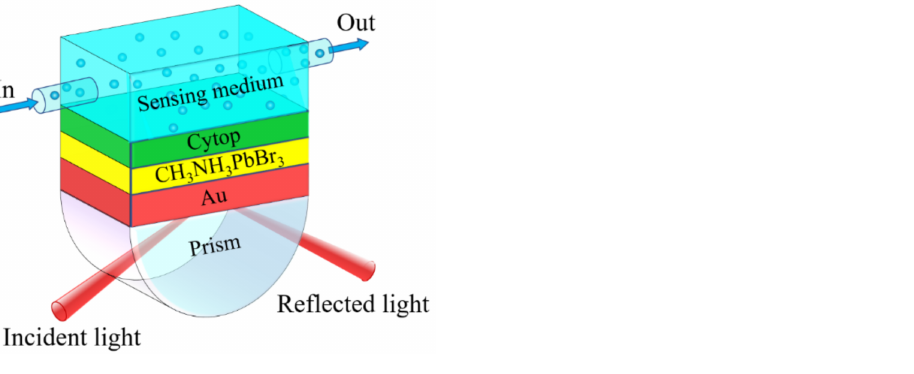
Figure 1. Schematic diagram of the guided-wave surface plasmon resonance (GWSPR) biosensor based on the Au–perovskite hybrid